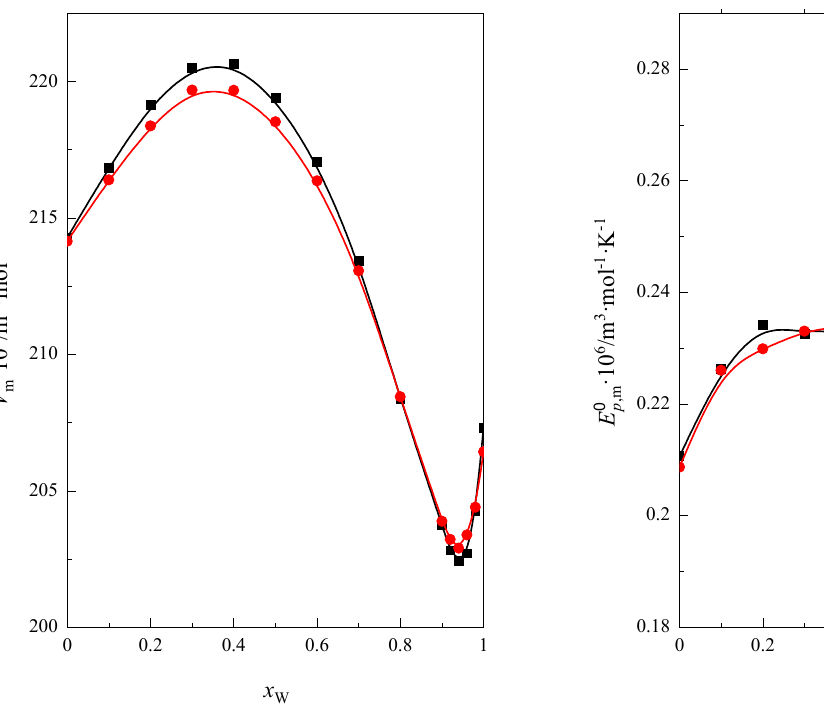
Figure 12. The courses of functions V 0 m = f ( x 2 ) , E 0 m = f ( x 2 ) , and K 0 calculated using experimental data [21,22], as represented by ■ , and the groups’ contribution is represented by ● .